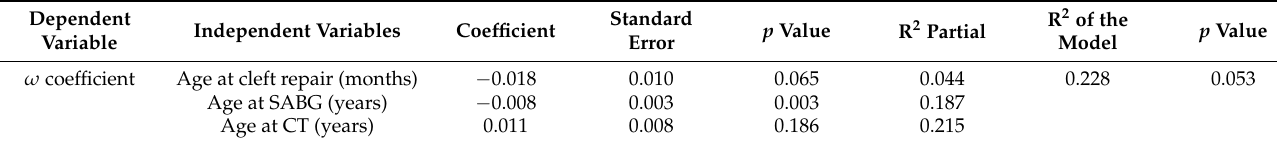
Table 3. Multiple regression model with ω coefficient as dependent variable and age at SABG, age at CT as independent variables. Dependent